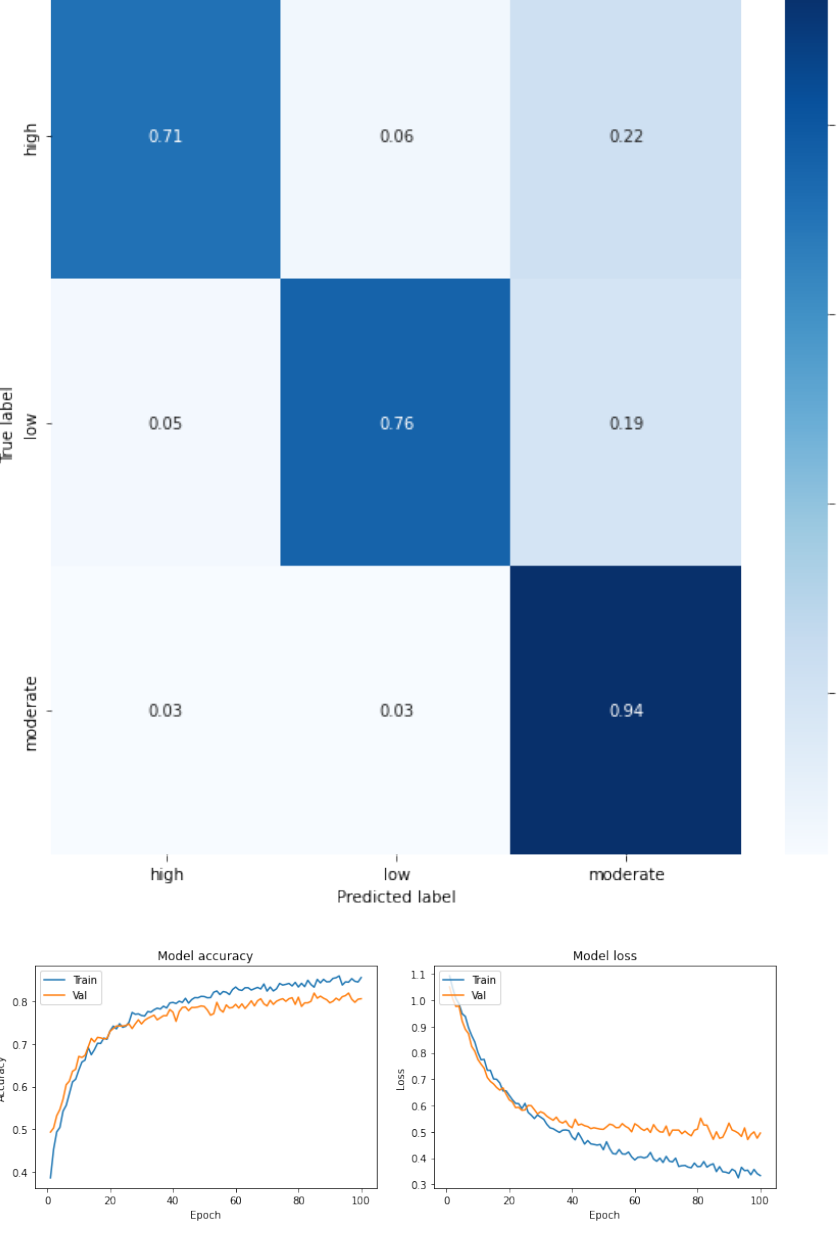
Figure 5. Confusion matrix, accuracy, and loss function for moderate osteoarthritis and the three levels of FOF. Table 7. Performance metrics for three classes of FOF and moderate